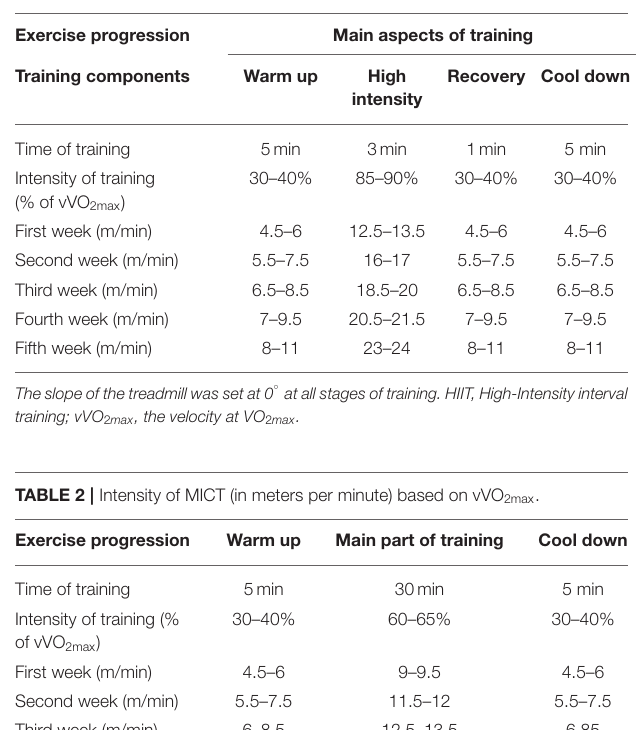
TABLE 1 | Intensity of HIIT (in meters per minute) based on vVO 2max